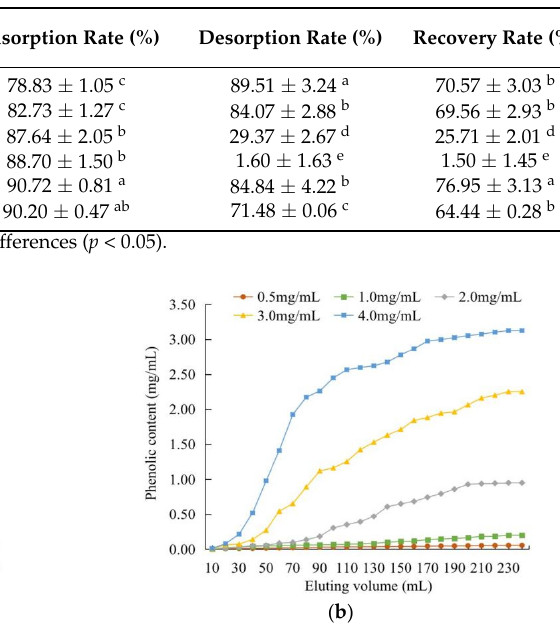
Table 5. Effects of the different types of macroporous resins on the adsorption and desorption of the phenolics.